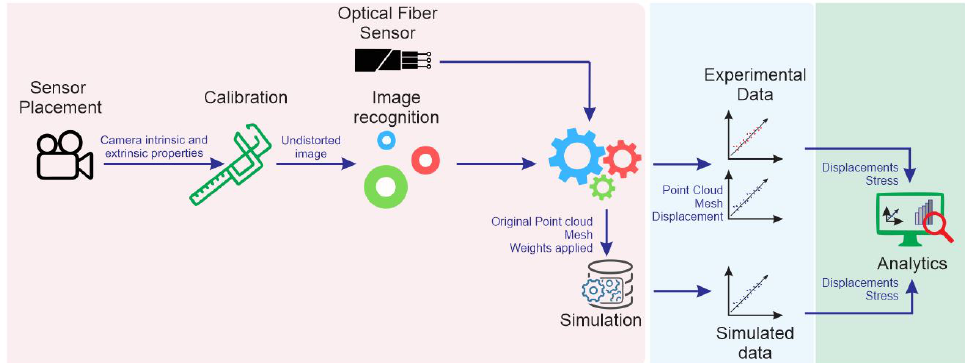
Figure 6. Experimental